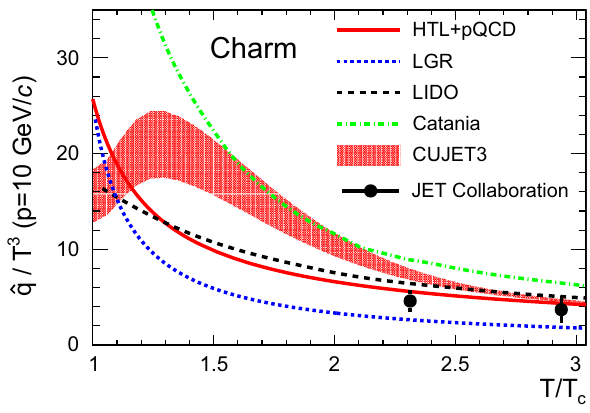
Fig. 5 Transport coefficient, ˆ q / T 3 ( T ) , of charm quark from the vari- ous calculations, including: the soft-hard factorized approach (solid red curve), the LGR model with data optimized parameters (dotted blue curve [40]), a Bayesian analysis from LIDO (dashed black curve [60]), a quasi-particle model from Catania (dot-dashed green curve [62]), CUJET3(shadowedredband[18,20,21])andJETCollaboration(black circle points [19]) at p = 10 GeV